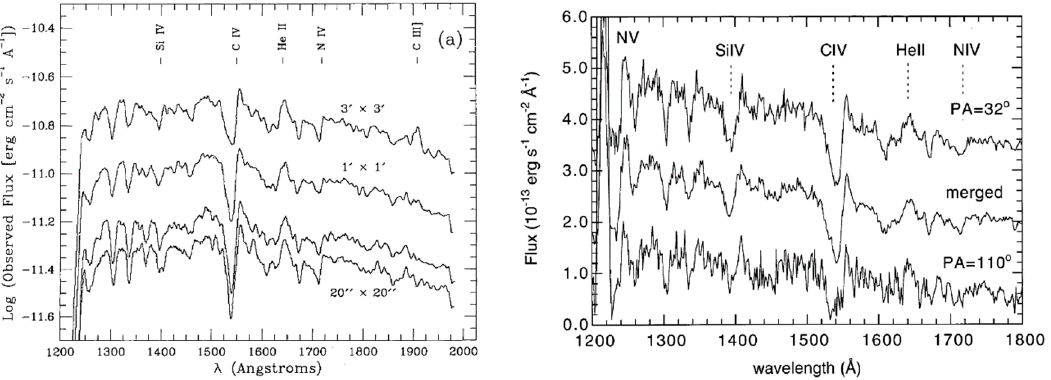
Figure 1. International Ultraviolet Explorer ( IUE ) spectra of NGC 2070 ( left ) and NGC 604 ( right ), two extragalactic massive star clusters and the Large Magellanic Cloud (LMC) and M33, respectively. The spectra show the typical UV spectral features of hot, massive stars. From [4,5].